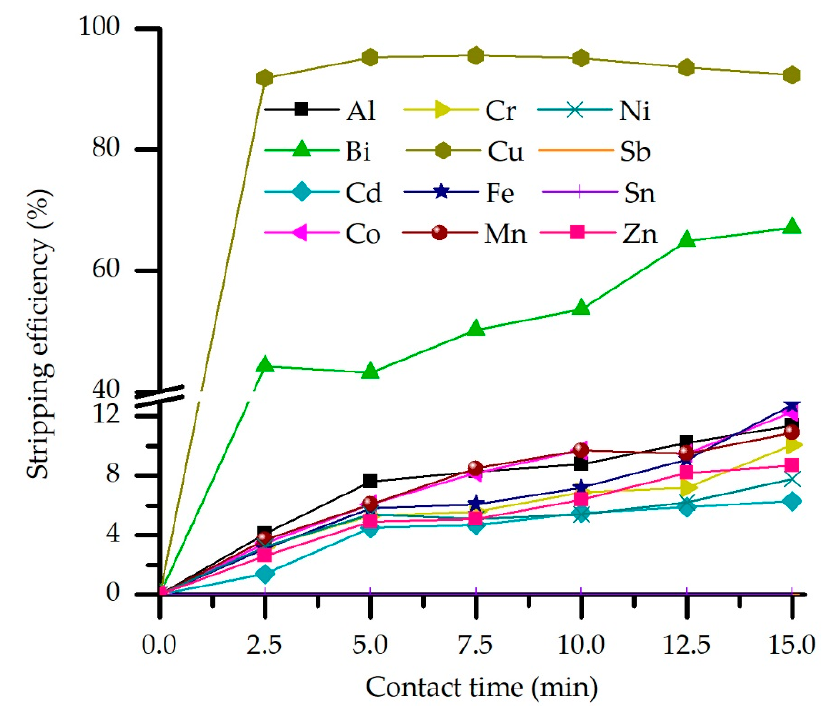
Figure 9. Effect of the phase contact time on the stripping efficiency (M5640 20 vol.% in loaded OP, H 2 SO 4 concentration 180 g/L, O/A = 2, and temperature 20 °C).